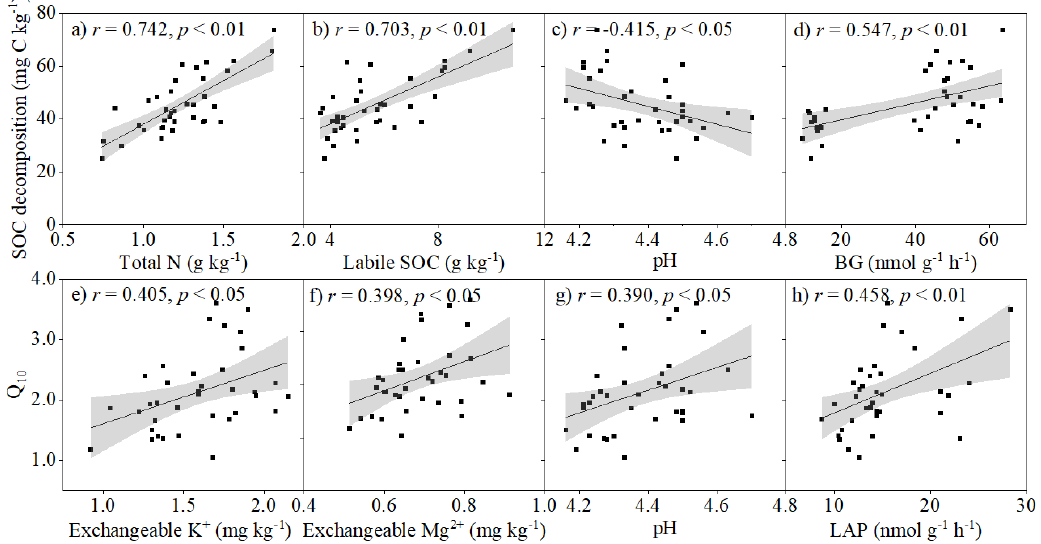
Figure 3. Effects of N and P fertilization on the activities of ( a ) β -1,4-glucosidase (BG), ( b ) β -N-acetyl- glucosaminidase (NaG), ( c ) leucine aminopeptidase (LAP), and ( d ) acid phosphatase (AcP) at 18 ◦ C at the end of incubation. F and A represent fertilization and soil aggregate size, respectively. Different letters on the bars denote significant differences among fertilization treatments. MeA, MaA, and MiA represent mega-aggregates (>2.0 mm), macroaggregates (0.25–2.0 mm), and microaggregates (<0.25 mm). Data were represented as the mean with standard error.